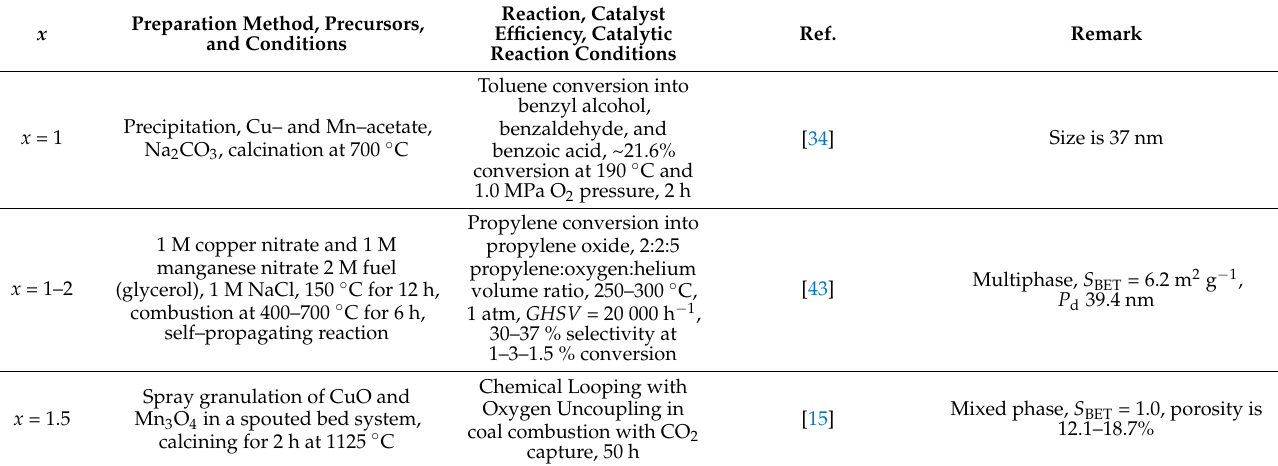
Table 13. Other industrial-scale reactions catalyzed by Cu x Mn 3 − x O 4